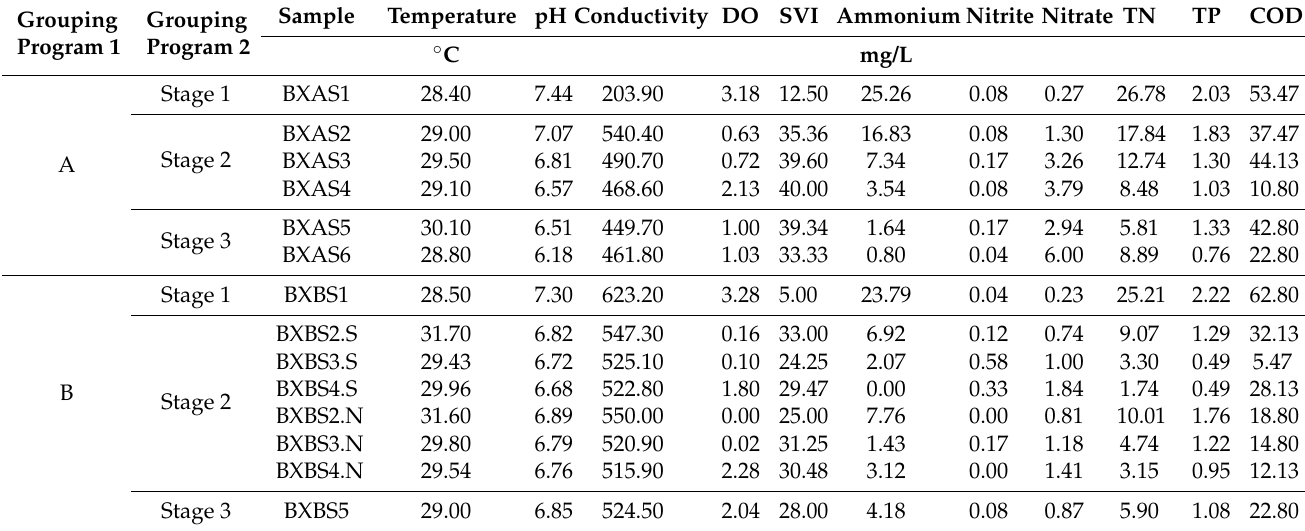
Table 1. Physicochemical parameters of wastewater treatment plants (WWTPs) under